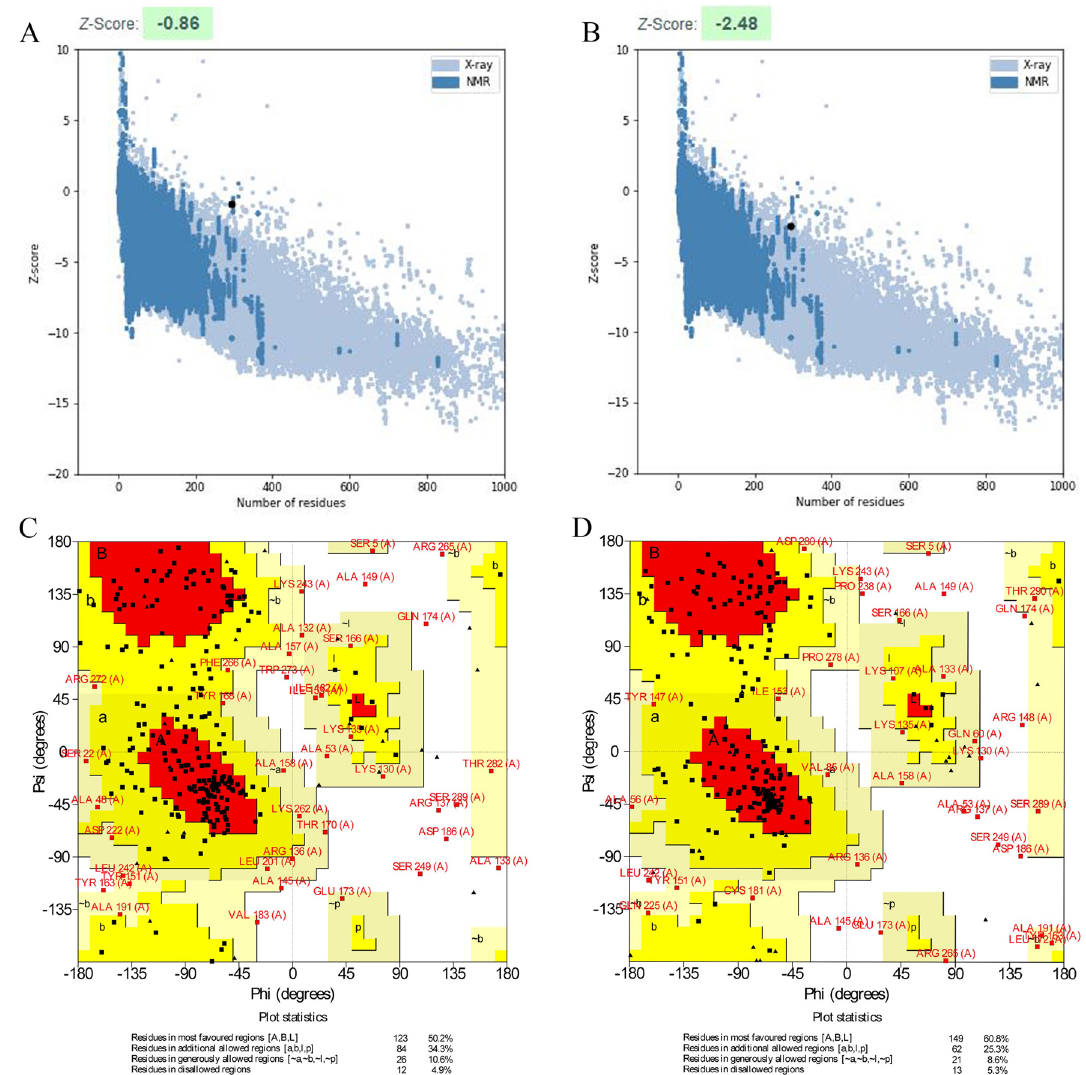
Figure 5. Evaluation of the 3D model of the vaccine construct using the ProSA-web and Ramachandran plot before and after the refining. ( A ) The initial model has a Z score of − 0.86, ( B ) while the refined model has a Z score of − 2.48. ( C ) The Ramachandran plot analysis shows that in the initial model, 50.2%, 34.3%, 10.6%, and 4.9% of the residues are found in the favoured, additional allowed, generously allowed, and disallowed regions, respectively, ( D ) while in the refined model, these values changed to 60.8%, 25.3%, 8.6% and 5.3%, respectively.